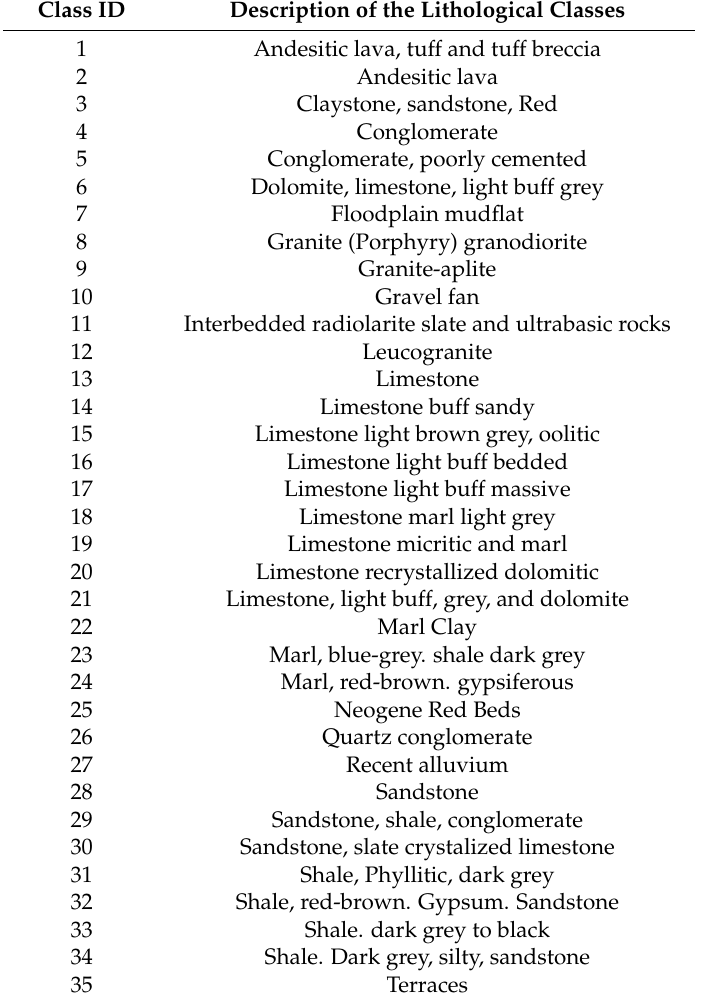
Table 1. The lithological units in the study